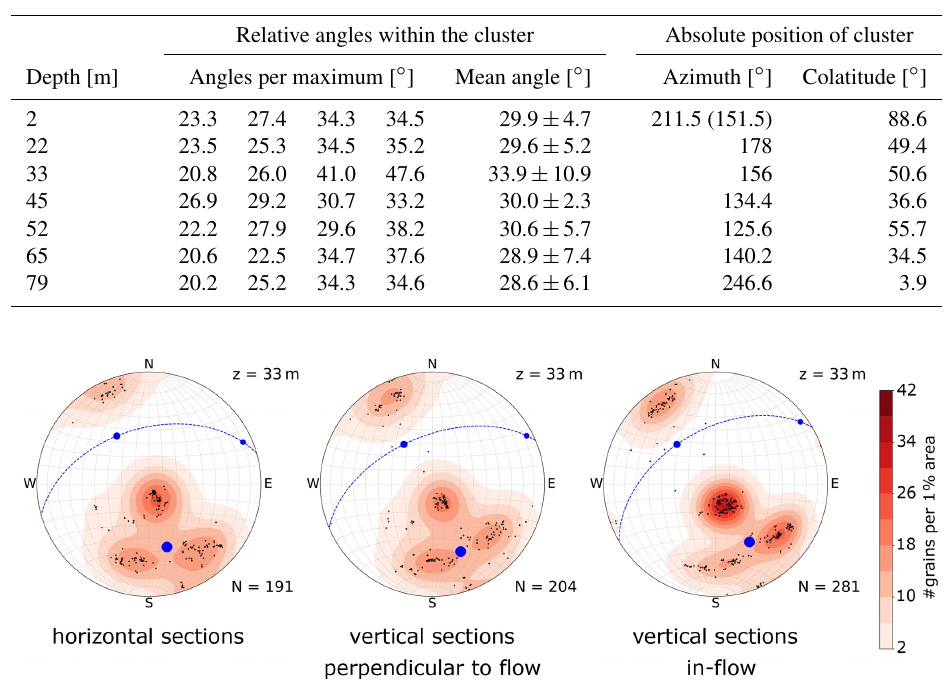
Table 1. Angles between individual maxima and the centroid, i.e. the largest eigenvector, describing the relative geometry of the multi- maxima pattern and the absolute orientation (azimuth and colatutide) of the centroid.